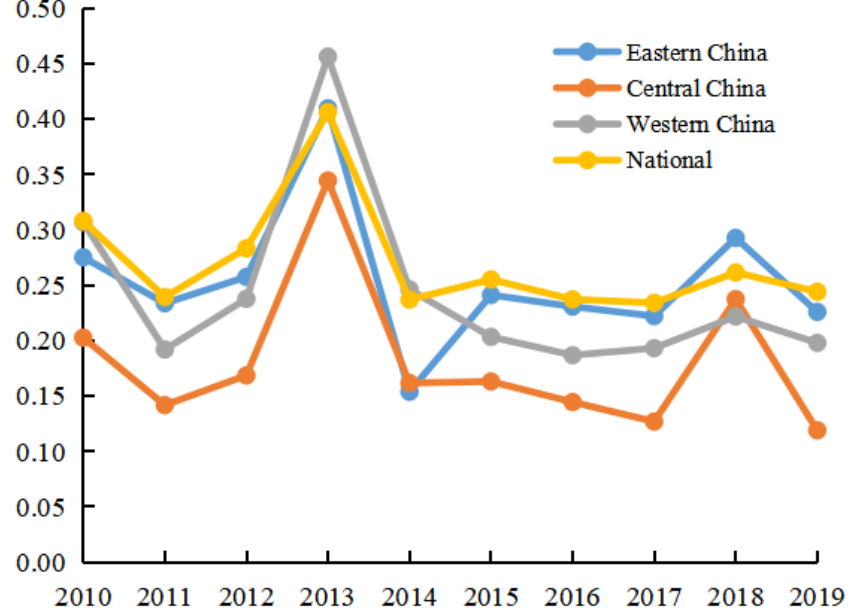
Figure 3. Variation coefficient of China’s green development level from 2010 to 2019.